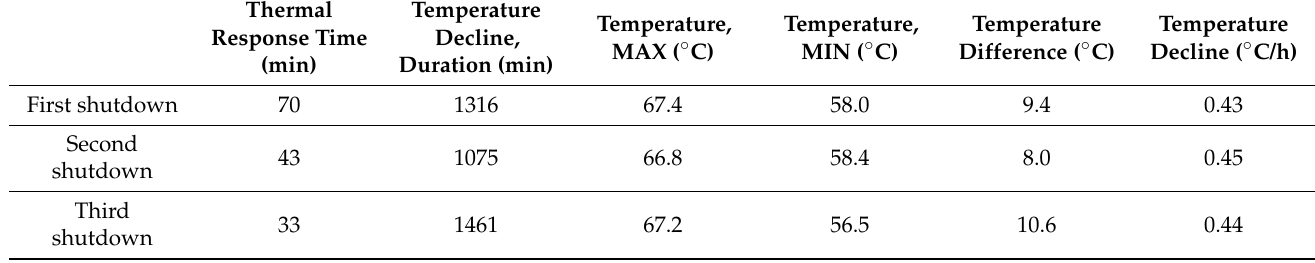
Table 4. The three shutdowns with thermal response times to the temperature declines, and temperatures at one of the drainage valves.